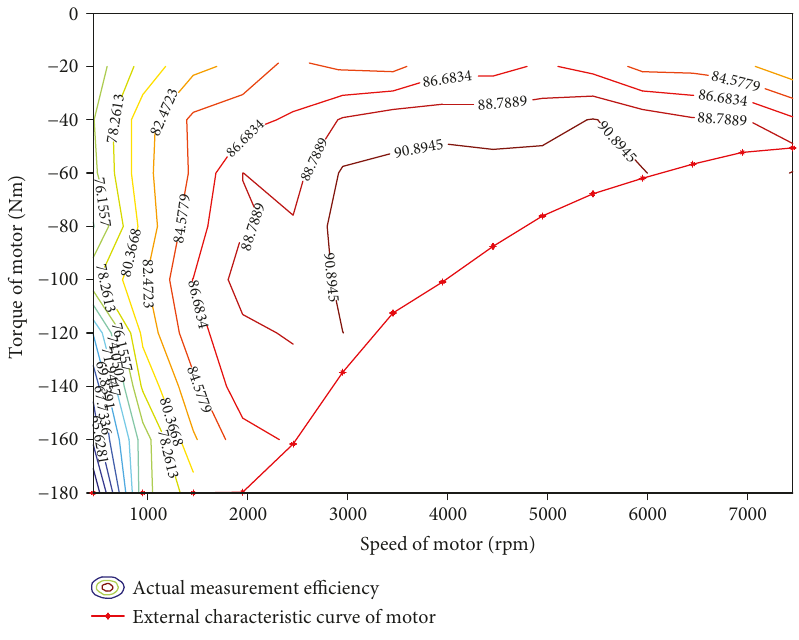
Figure 5: Measured map characteristic curve of motor.